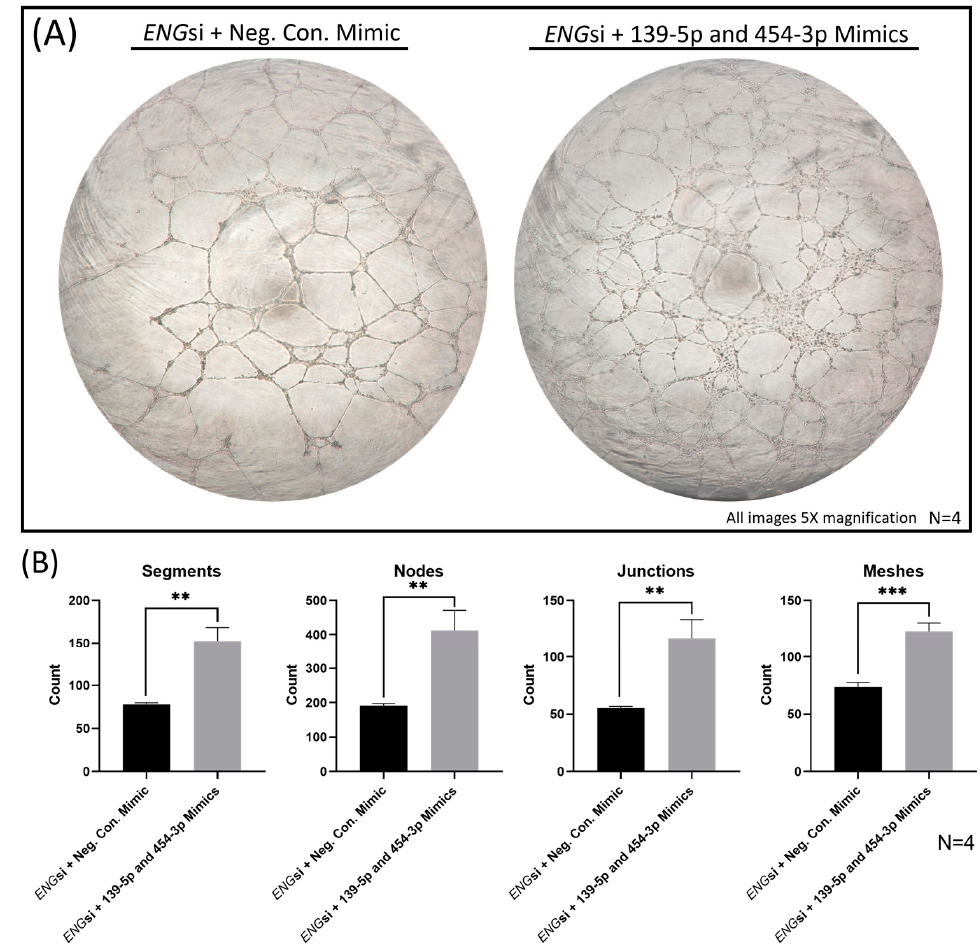
Figure 9. In vitro tube formation assay of ENG -knockdown ( ENG si) HUVECs with either negative control mimics (Neg. Con. Mimic) or 139-5p/454-3p mimics. ( A ) Images of ENG si + Neg. Con. Mimics and ENG si + 139-5p and 454-3p mimics were taken at 16 hours (5 × magnification). ( B ) Significantly increased counts of segments, nodes, junctions and meshes were detected in ENG -knockdown HUVECs with 139-5p/454-3p mimics compared with those in negative control mimics (N = 4). ** p < 0.01, *** p < 0.001.